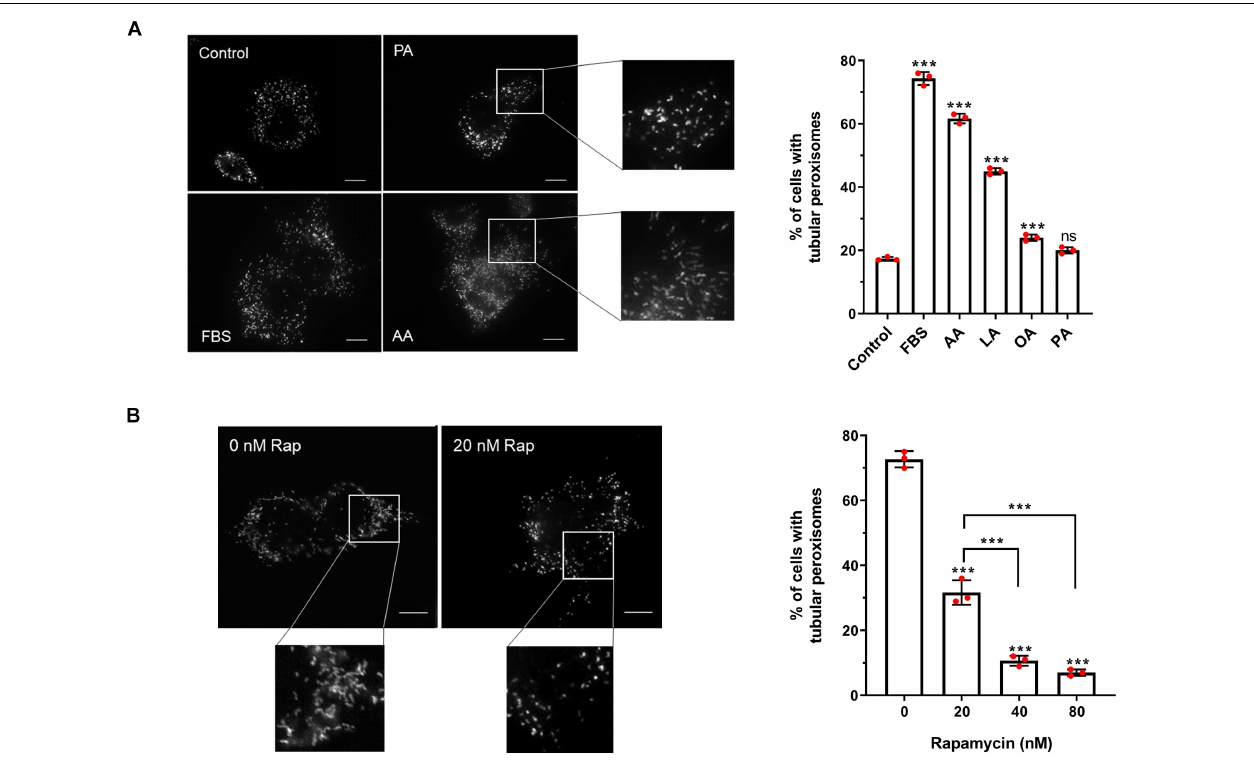
FIGURE 2 | Effect of fatty acids and rapamycin on peroxisome elongation in HepG2 cells. (A) Quantitative analysis of peroxisome morphology upon stimulation with 50 µ M fatty acids in HepG2 cells cultured in MEM/N1 for 24 h. Note the strong stimulatory effect of PUFAs (AA and LA). (B) Quantitative analysis of peroxisome morphology after treatment of HepG2 cells with rapamycin and subsequent serum stimulation. Data in (A,B) are based on immunofluorescence microscopy using anti-PEX14 from 3 independent experiments ( n = 300 cells in each condition); analyzed by one-way ANOVA with Dunnett’s (A) or Tukey’s (B) post hoc test; *** p < 0.001. AA, arachidonic acid; LA, linoleic acid; OA, oleic acid; PA, palmitic